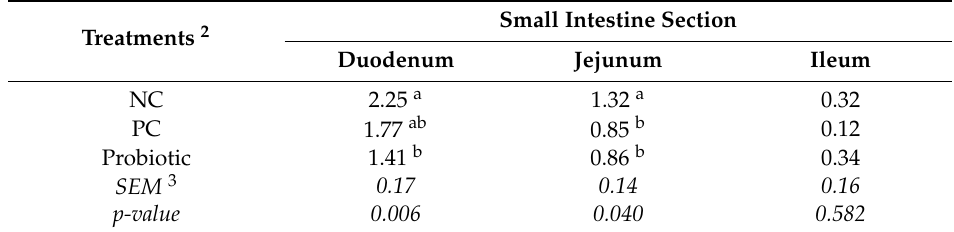
Table 4. E ff ect of antibiotic growth promoter or probiotic supplementation in the diet on intestinal lesion scores of broiler chickens under naturally occurring necrotic enteritis challenge.